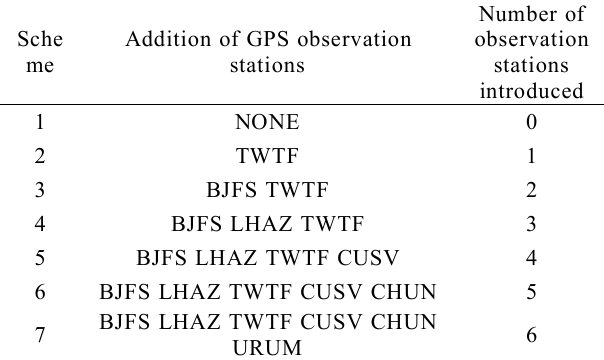
Table 1 Addition of test scheme of auxiliary stations